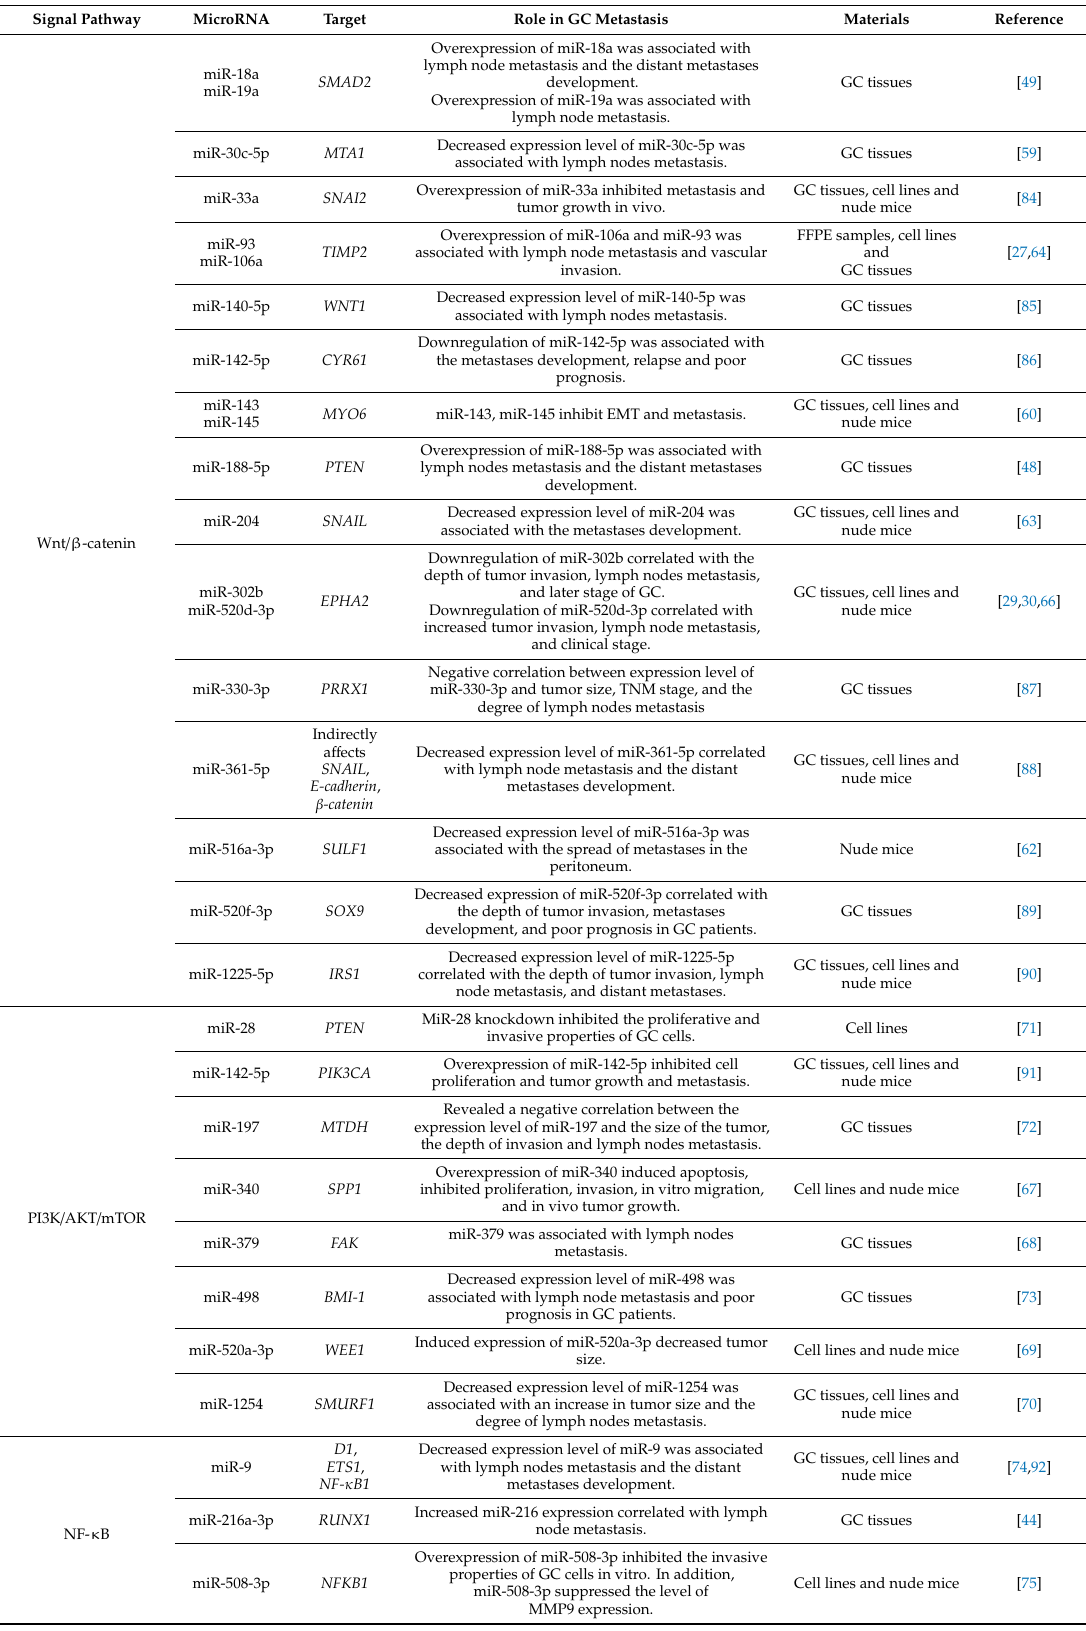
Table 1. The microRNAs involved in GC metastasis, their direct targets and regulated signaling pathways. Signal